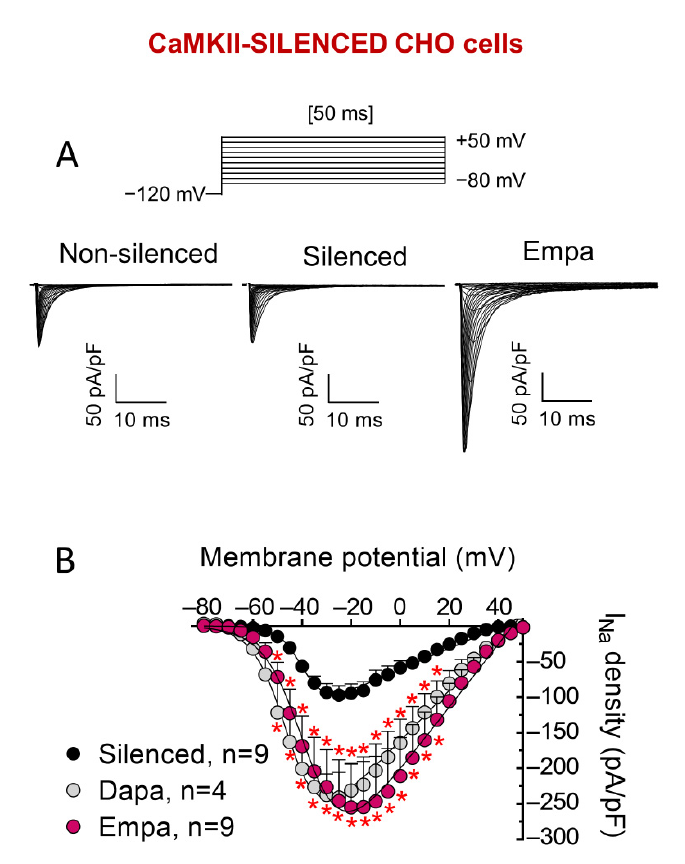
Figure 6. Neither dapa- nor empa-induced increase of I Na was mediated by CaMKII. ( A ) I Nav1.5 traces recorded, using the protocol shown at the top, in a non-silenced CHO cell and in two different CHO cells in which CaMKII expression was reduced by 65% by means of specific siRNA. The latter cells were incubated with empa (1 µ M, 24-h) or not (Silenced). ( B ) I Nav1.5 density-voltage relationships obtained in CAMKII-silenced CHO cells incubated with dapa or empa or not incubated. In ( B ), each point is the mean ± SEM of the “n” experiments indicated in the figure. * p < 0.05 vs. control.